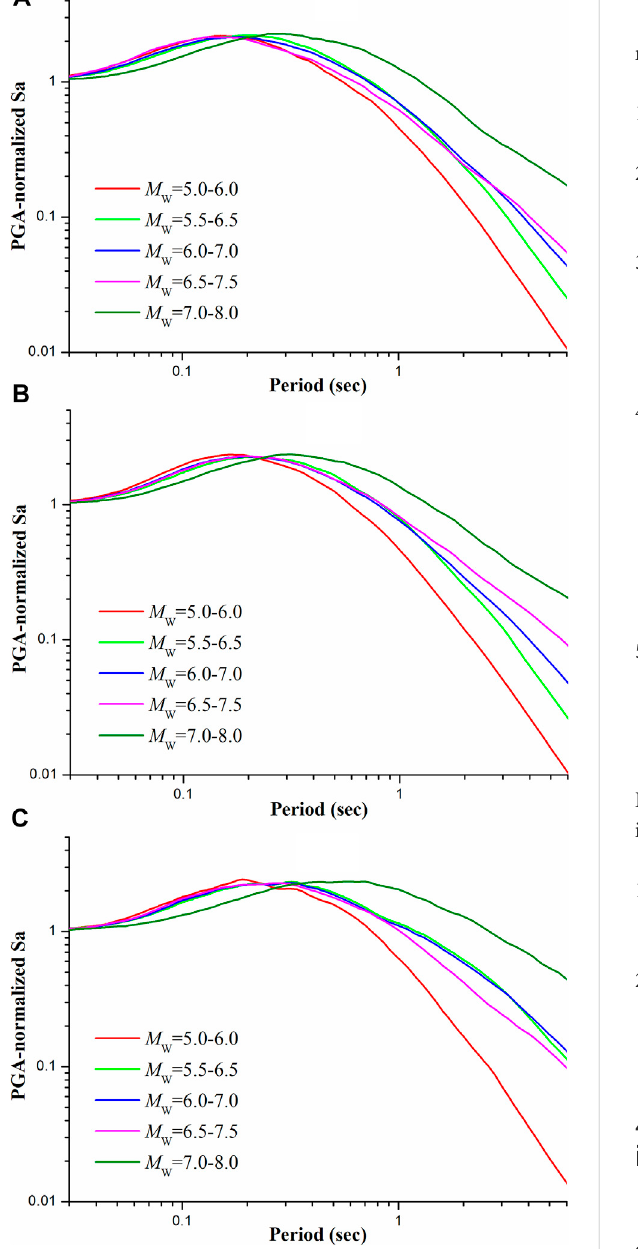
Frontiers in Earth